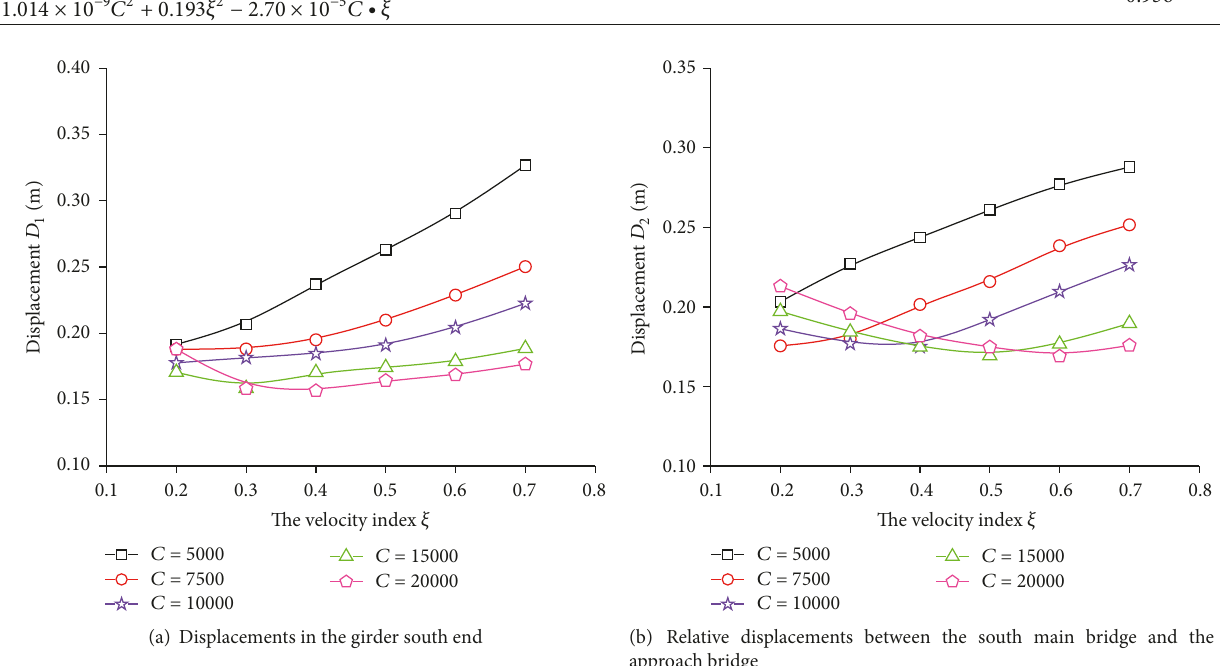
(b) Relative displacements between the south main bridge and the approach bridge Figure 6: Change of controlled displacements with damping parameters.